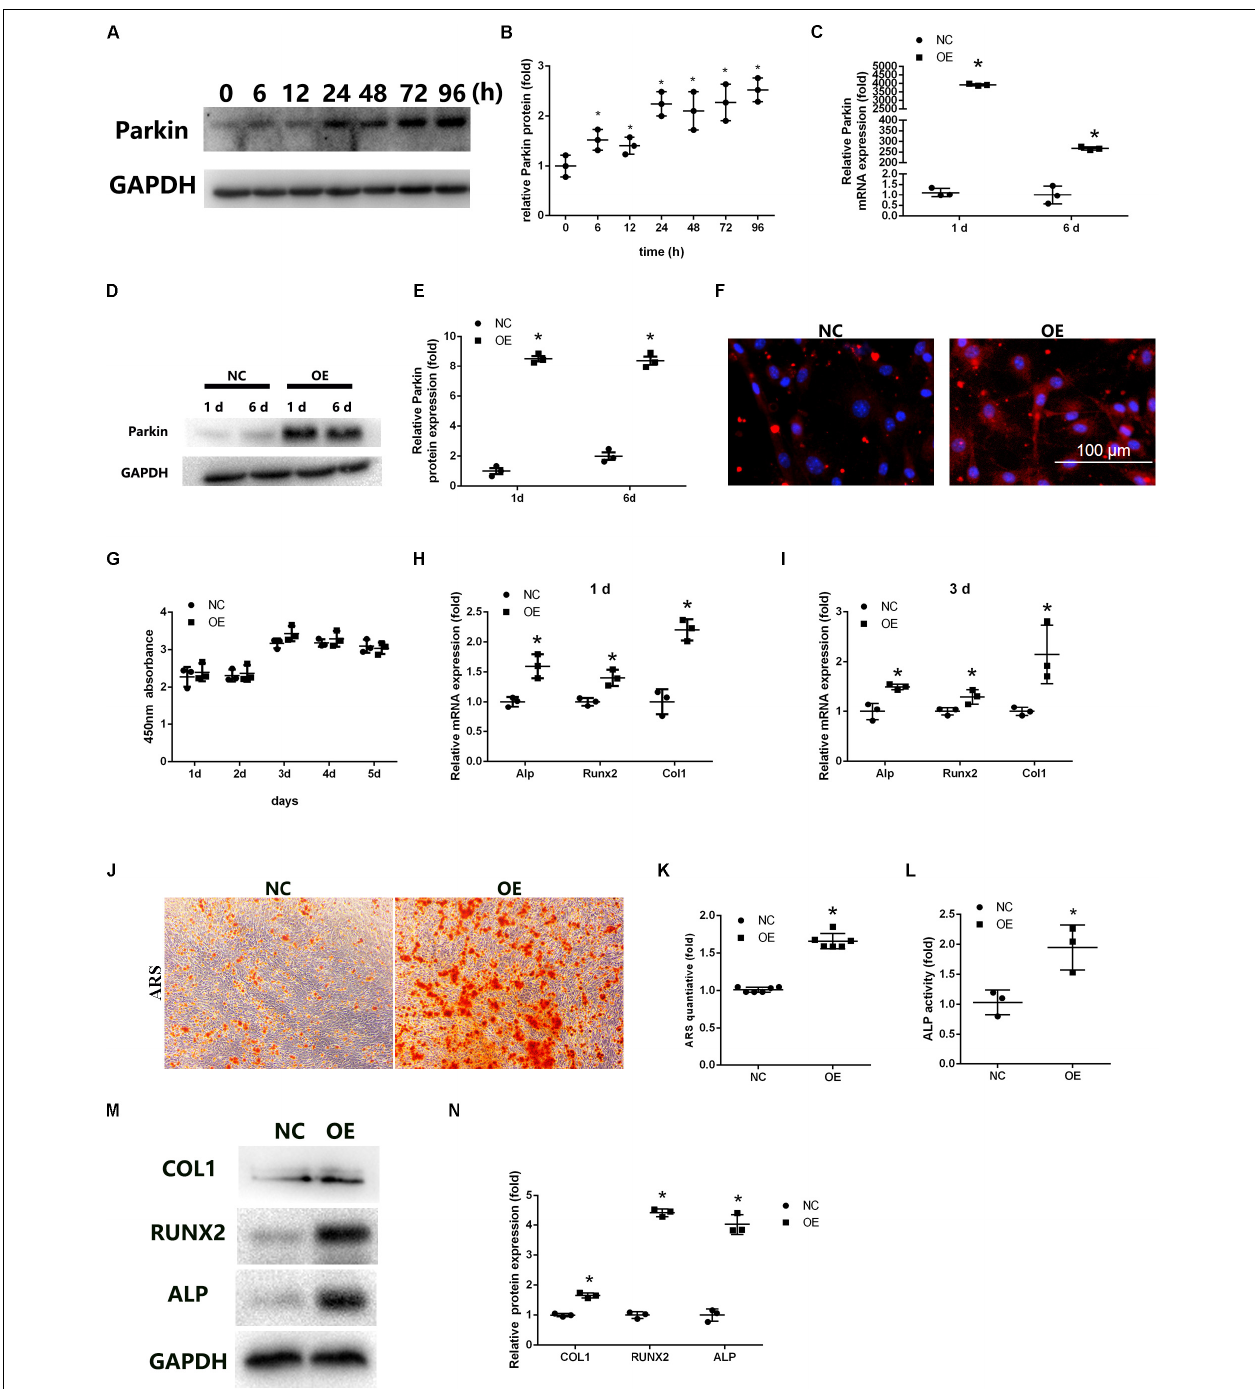
FIGURE 1 | Overexpression of Parkin enhances osteoblastic differentiation of bone marrow mesenchymal stem cells (BMSCs). (A,B) Protein expression levels of Parkin were determined at 0, 6, 12, 24, 48, 72, and 96 h after induction of osteoblastic differentiation. (C) mRNA expression of Parkin was analyzed by quantitative real-time polymerase chain reaction (RT-qPCR) at days 1 and 6 after infection. (D,E) Protein expression of Parkin was analyzed by western blot (WB) analysis at days 1 and 6 after infection. (F) Protein expression of Parkin was analyzed by immunofluorescence staining at day 6 after infection. (G) Proliferation was detected by Cell Counting Kit-8 in the Parkin-overexpressed and control group at days 1, 2, 3, 4, and 5. (H) Osteo-specific genes Alp, Runx2, and Col1 were analyzed by RT-qPCR at day 1 after osteogenic induction. (I) Osteo-specific genes Alp, Runx2, and Col1 were analyzed by RT-qPCR at day 3 after osteogenic induction. (J,K) Mineral deposits were determined by Alizarin Red staining at day 12 after osteogenic induction. (L) Alkaline phosphatase activity at day 3 of osteogenic differentiation of BMSCs. (M,N) Osteo-specific proteins Alp, Runx2, and Col1 were analyzed by WB at day 3 after osteogenic induction. Data are expressed as the mean ± standard deviation (SD) ( n = 3). NC, BMSCs transfected with negative control adenovirus vectors; OE, BMSCs transfected with Parkin-overexpressed adenovirus vectors; * P < 0.05 vs. BMSCs in the NC group.